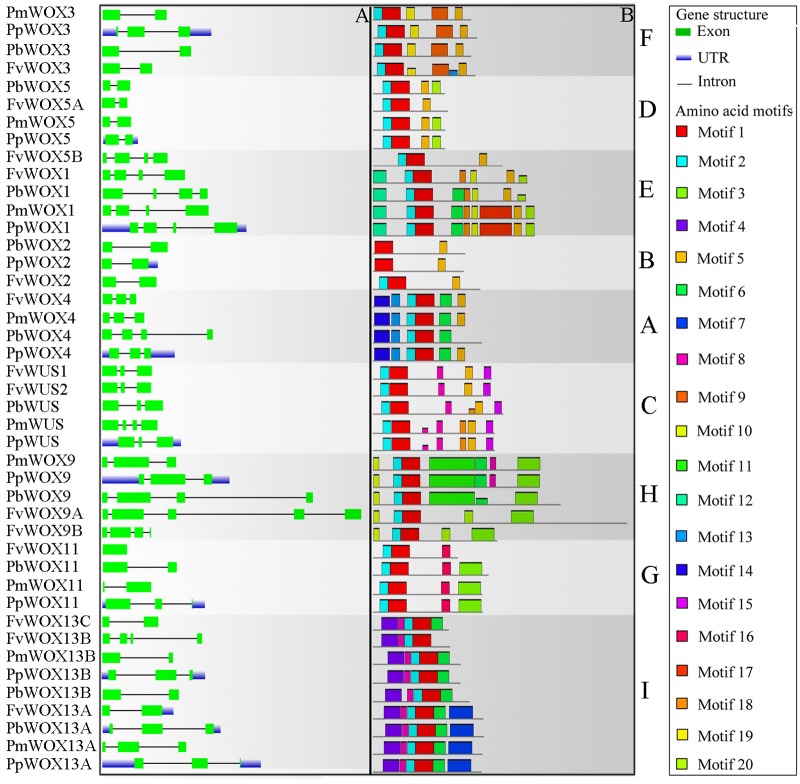
Exon/intron structure (A) and motif compositions (B) of the Rosaceae WOX genes. Relative protein or gene lengths can be estimated by gray bars. Untranslated regions (UTRs), exons and introns are represented by blue lines, green boxes and gray lines, respectively. Motif sequences were shown in Supplementary Table S2. The A-I subfamilies in figure were consistent with those in Figure 2.